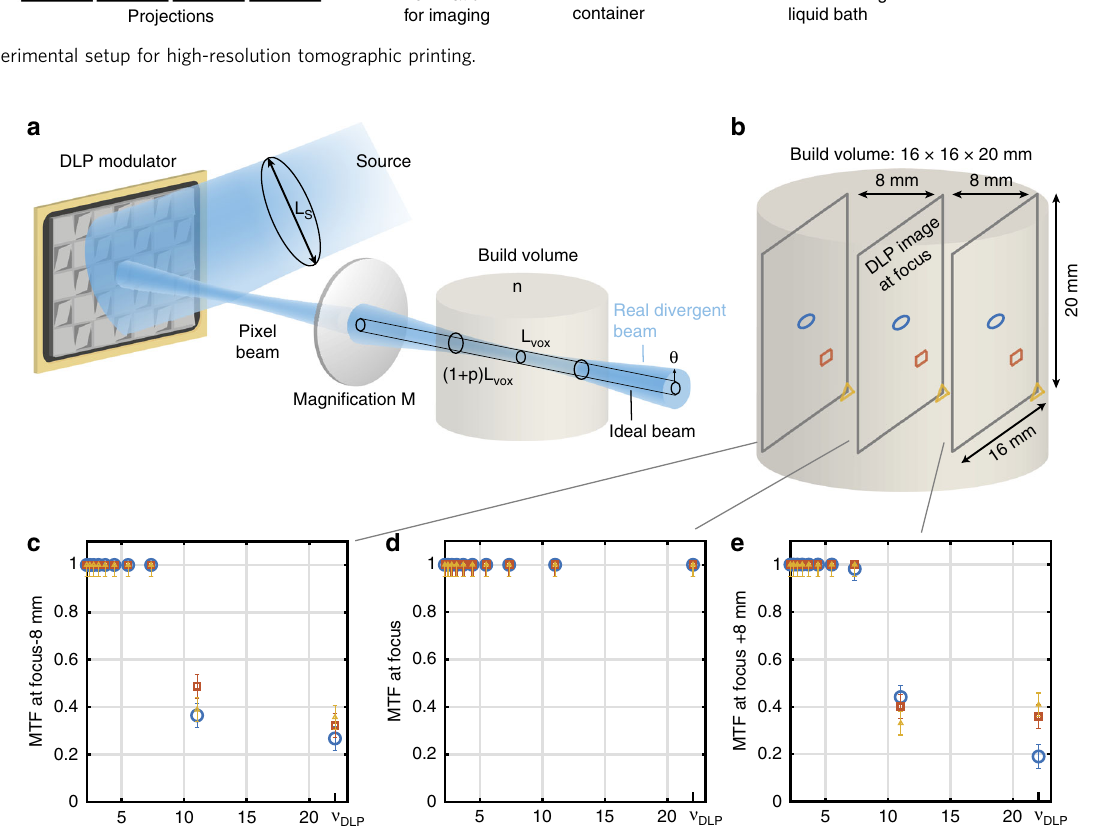
Fig. 2 Optical resolution in tomographic AM. a étendue-limited optical resolution. b Experimental measurement points on-axis (blue circle), at mid- fi eld, (red square) and edge of fi eld (yellow triangle) of the modulation transfer function (MTF) in the build volume of our tomographic printer. c Experimental MTF as a function of the spatial frequency 8 mm ahead of the focal plane, d at focus and e 8 mm after focus. The error bars represent the standard deviation of fi ve repeated measurements at a point at the edge-of- fi eld point at focus, and the error value for the other points were assumed to be the same (see Supplementary Note To achieve high-resolution tomographic AM, six laser diodes function (MTF) performed over the build volume of our were coupled in a square core fi ber ( L S = 70 μ m) of numerical tomographic volumetric printer (see Fig. 2c – e and Supplemen- aperture NA S = 0.22, yielding a theoretical optical resolution of tary Note 3) are consistent with the above theoretical 23 µm in the center of the 16 mm × 16 mm × 20 mm build calculations as the maximal spatial frequency of the DLP volume and of 33 µm on the edge (see Supplementary Note 2 modulator υ DLP = 21.9 cycles per mm can be reached over the for a detailed calculation). These spread values of the pixel whole DLP fi eld in the center of the build volume whereas the images correspond to maximum spatial frequencies of 21.9 printer ’ s MTF decreases on the edge of the build volume to ~0.4 cycles per mm and 15.2 cycles per mm, respectively. The for a spatial frequency of 11 cycles per mm, which corresponds experimental measurements of the modulation transfer to a 27 µm optical resolution.